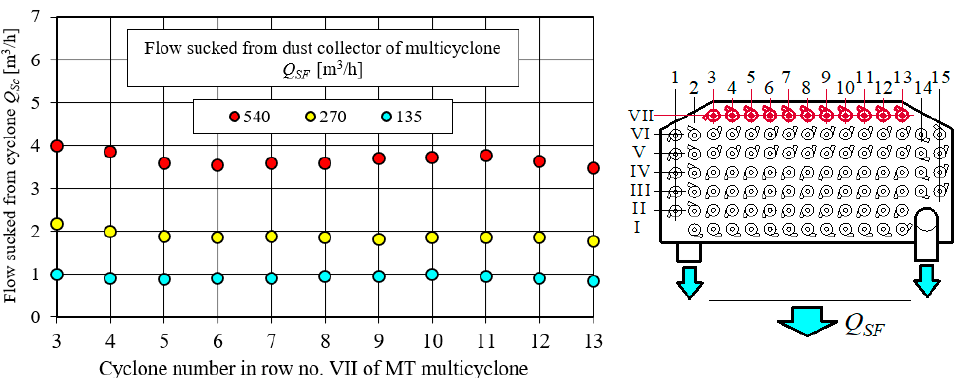
Figure 24. The values of the sucked flows Q Sc from the individual cyclones of the first (I) row of the MT multicyclone.